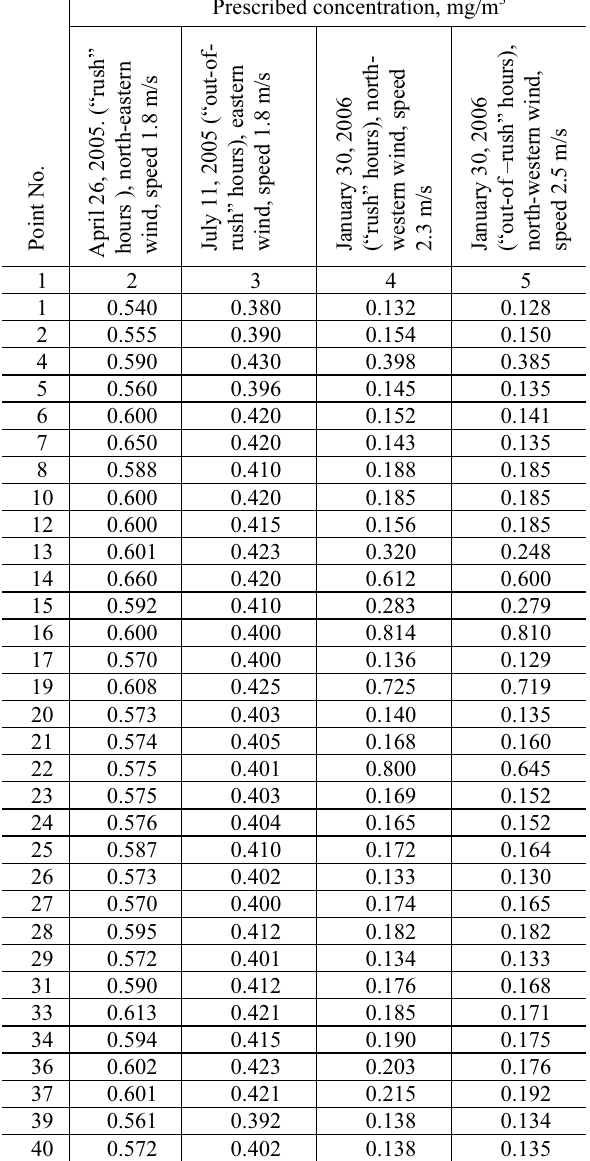
Table 1. Calculation of initial conditions